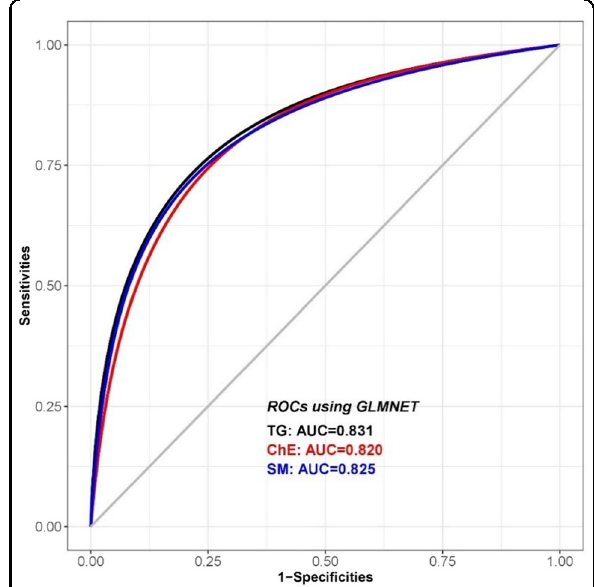
Fig. 5 ROC of TG, ChE, and SM lipid models in the classi fi cation of AD versus control by GLMnet. SM sphingomyelins, ChE cholesteryl esters, TG triglycerides, GLMnet elastic net penalization for the generalized linear